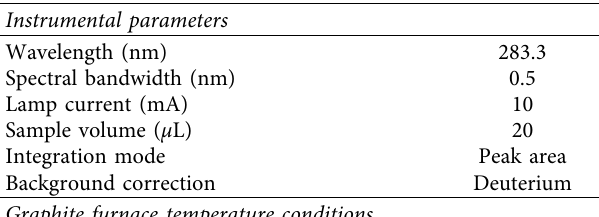
Table 1: Instrumental parameters and graphite furnace temper- ature conditions for Pb